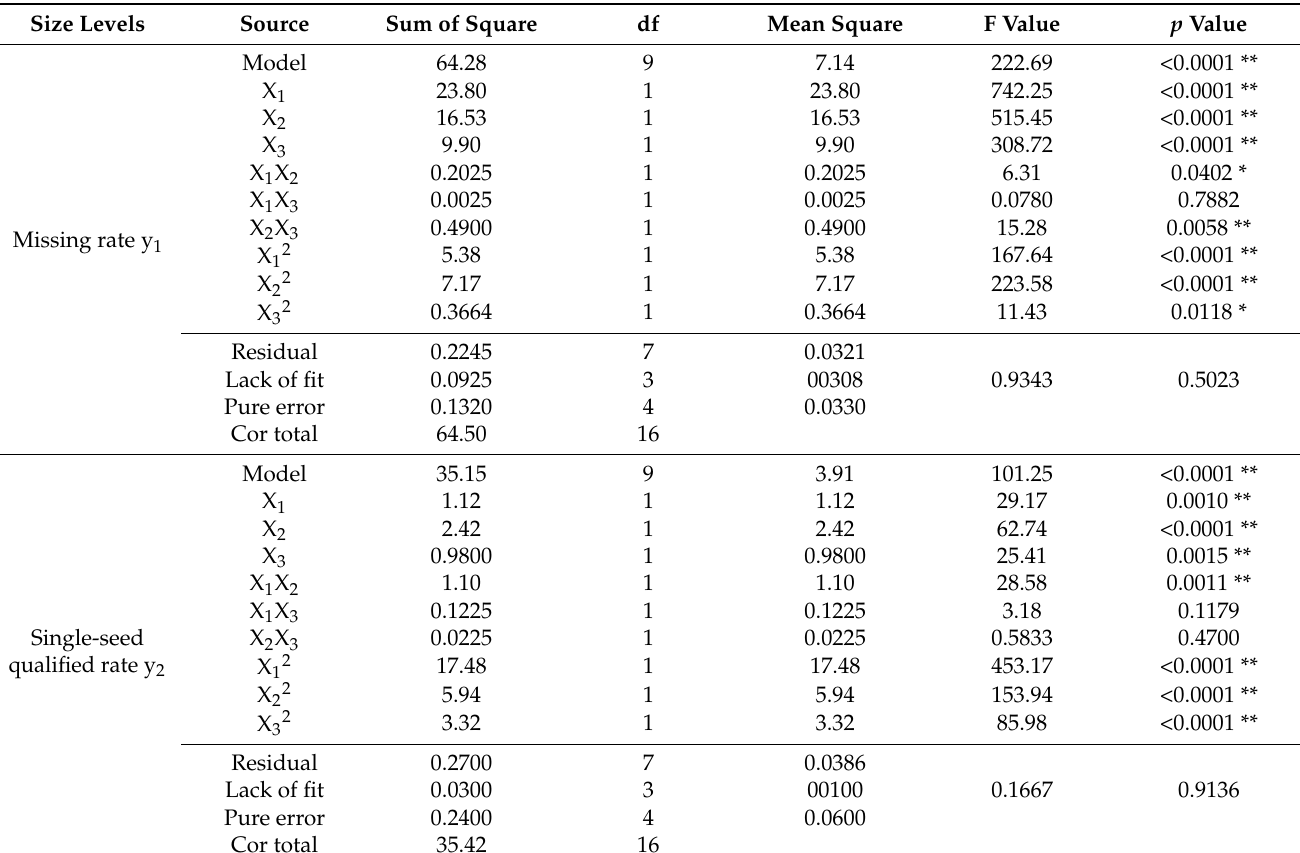
Table 6. Variance analysis of regression